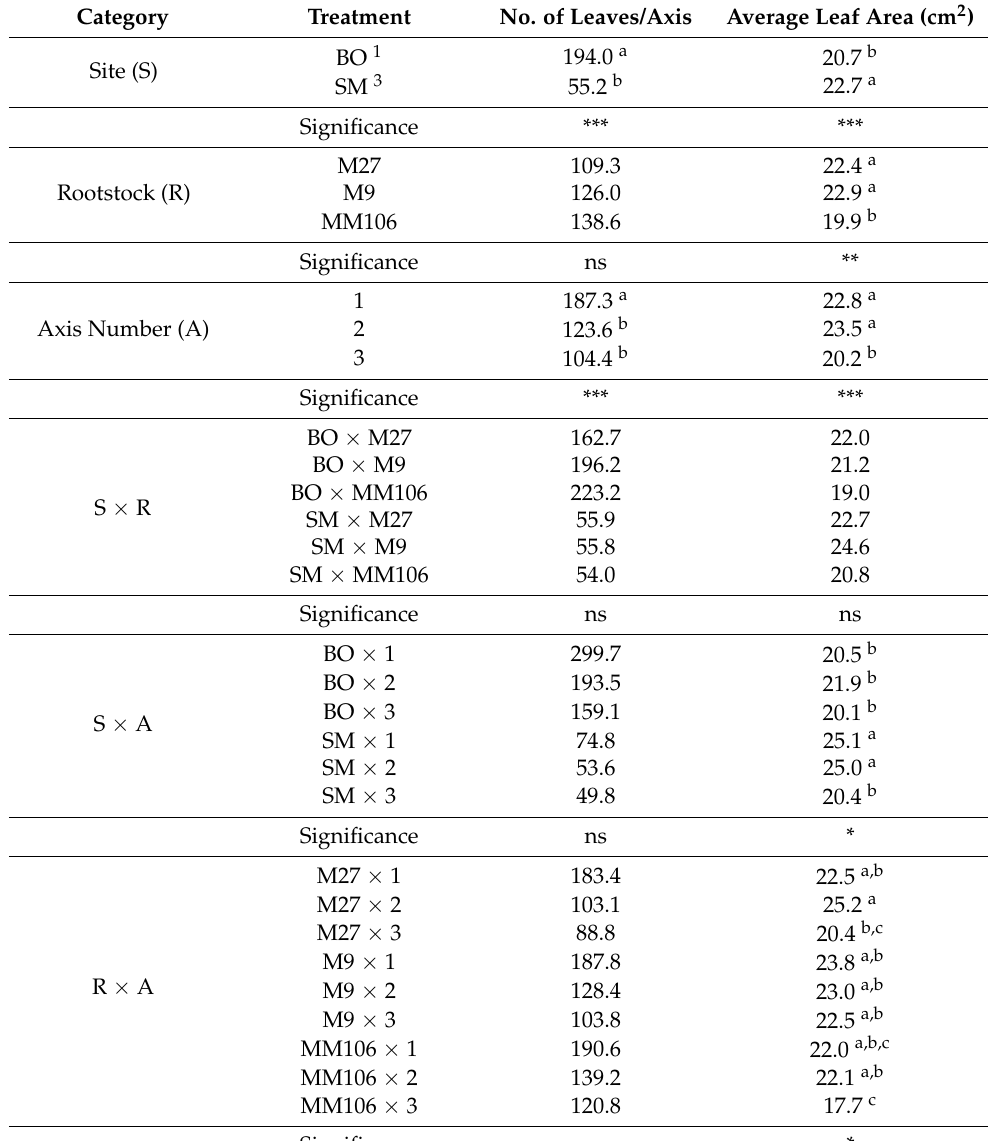
Table 2. Main effects of site of cultivation, rootstock, axis number, and their interactions on number of leaves per axis and average leaf area in ‘Fuji’